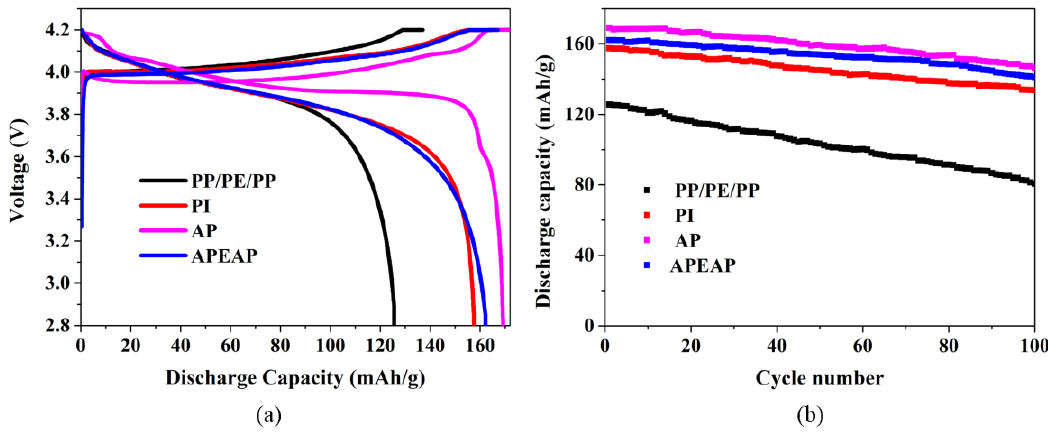
Figure 8. Cycling performance of different Li/LiCoO2 cells containing various separators at 0.2 C: ( a ) First charge-discharge curves of different Li/LiCoO2 cells containing; ( b ) The 100 times charge-discharge curves.